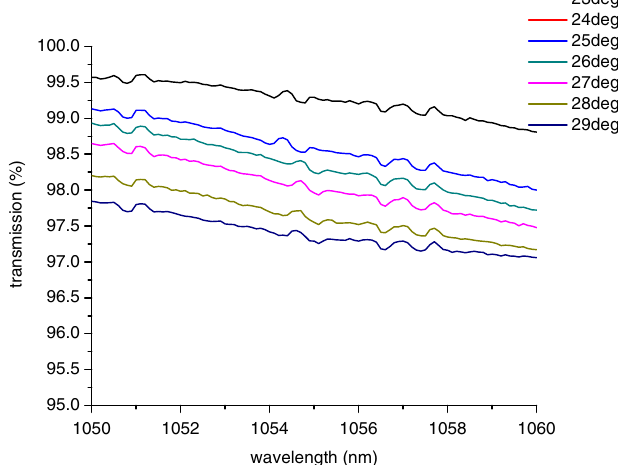
FIG. 6. (Color) Spectral transmission through AR coated nitro- cellulose at various angles of incidence and a wavelength band- width of 10 nm.